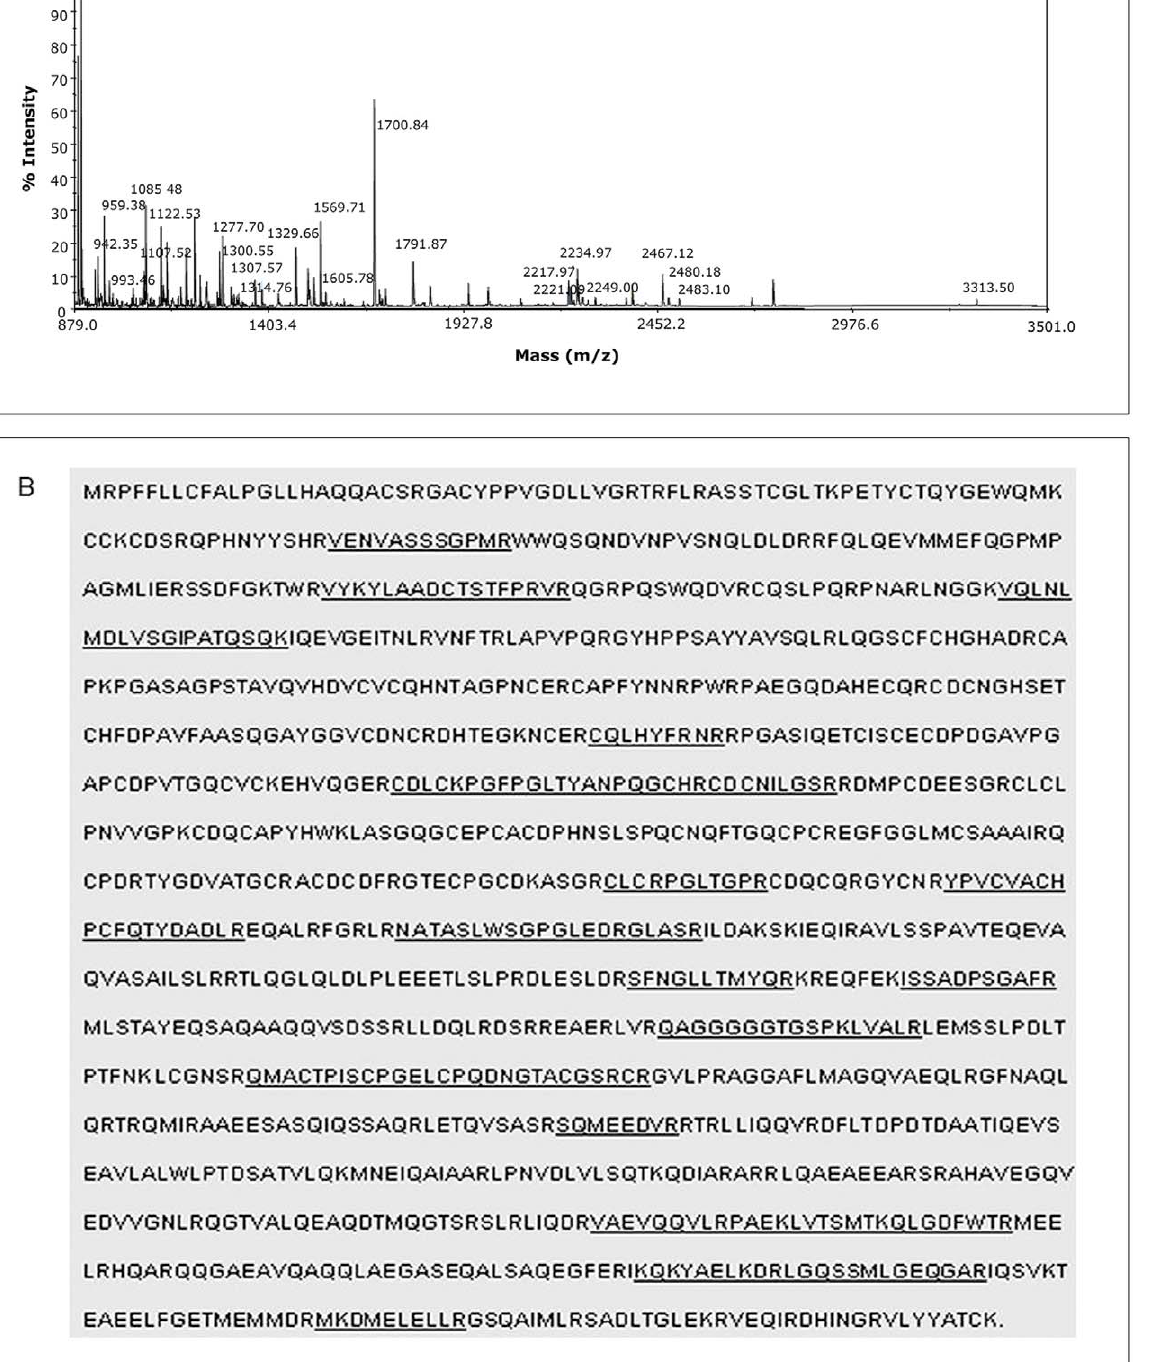
Figure 5. Matching of the amino acid sequences of the 130 kDa protein of Oncopeltusfasciatus salivary glands with the human laminin-5 b 3 chain amino acid sequence. ( A ). Protein spots cut from the gel were treated with porcine trypsin and the peptides were spotted onto a MALDI-TOF sample plate (Voyager- DE, Applied Biosystem, CA, USA). Peptide mass fingerprints were analyzed using Protein Prospector MS-Fit interface (http://prospector.ucsf.edu). ( B ). Underlined letters represent the amino acid sequences of the salivary gland protein that matched the mass spectrometry data to protein sequences in the NCBI database. The underlined sequences indicate the peptides of the salivary gland protein that were matched with the amino acid sequence of the precursor of the human laminin-5 b 3 chain.